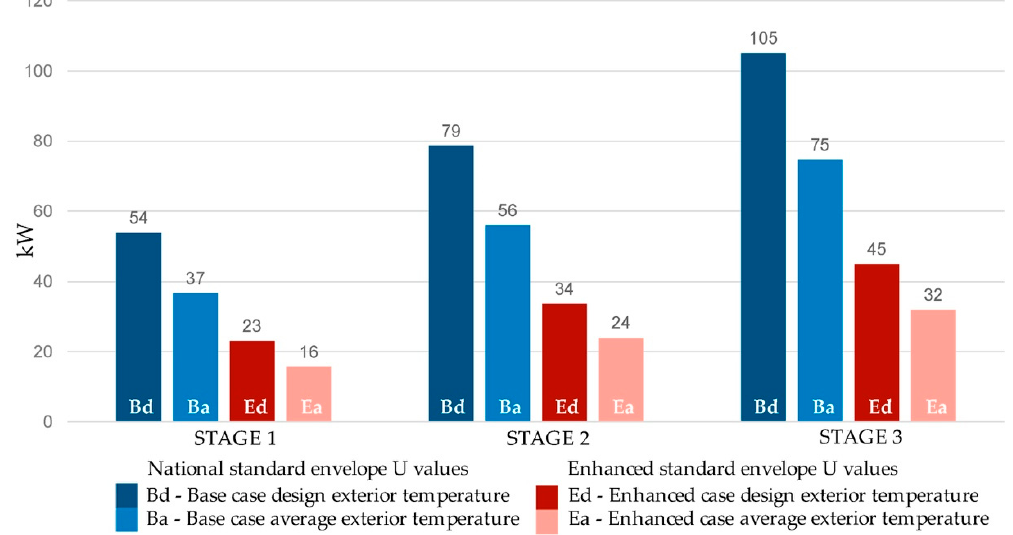
Figure 14. Power needed for heating.